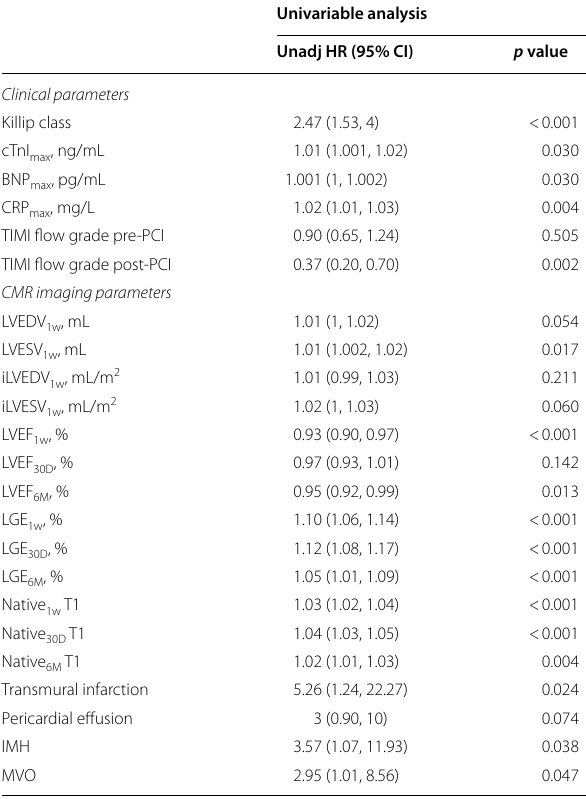
Table 3 Clinical and CMR predictors of MACE in univariable cox regression analysis for patients with and without